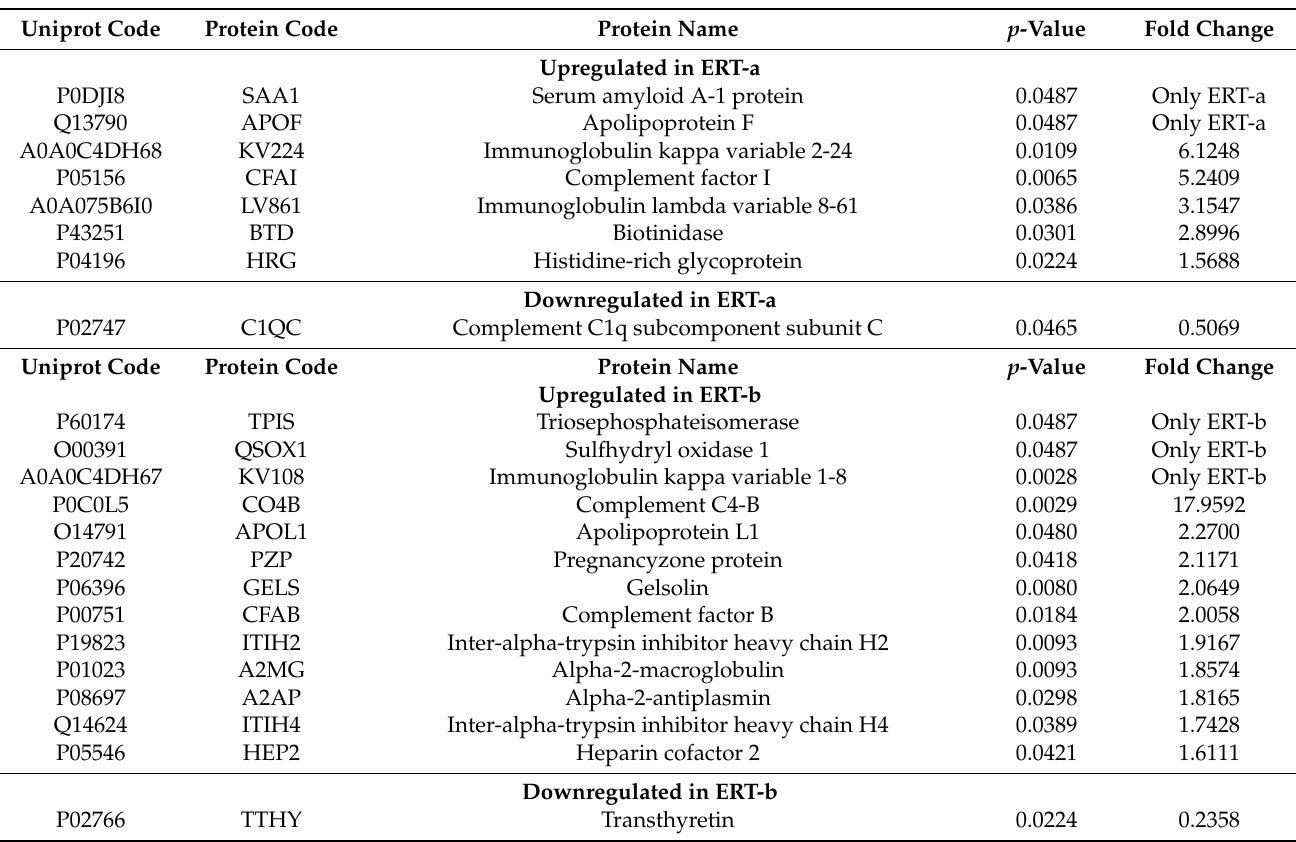
Table 4. Changes in protein expression in the ERT-a or ERT-b groups relative to all other groups. Protein expression is considered altered in cases in which p < 0.05 and the fold change >1.5 (upregulated proteins) or <0.6 (downregulated